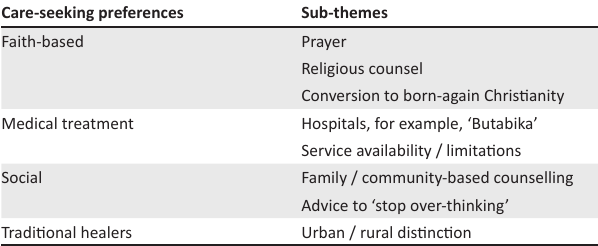
TABLE 3: Care-seeking preferences discussion